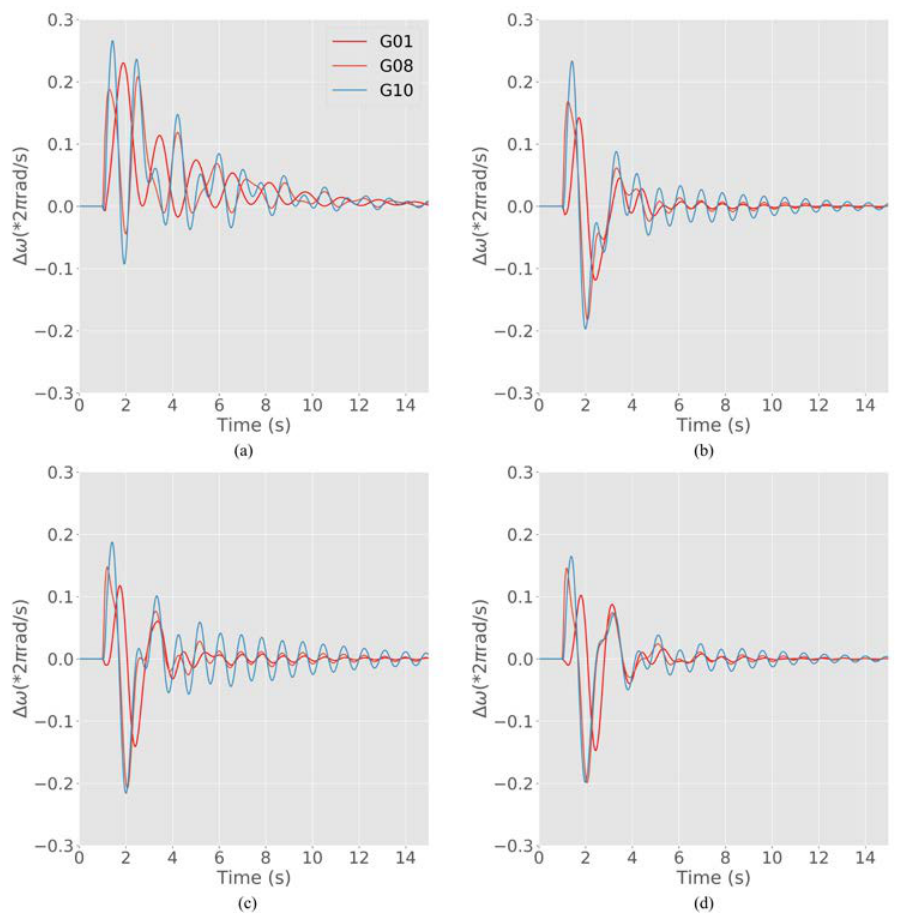
Figure 6. The deviation and the derivative of ω . ( a ) No high-voltage direct current (HVDC); ( b ) Case 1; ( c ) Case 2; ( d ) Case 3.